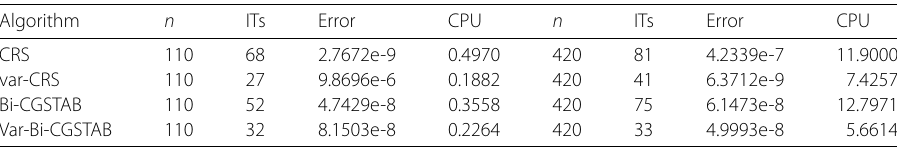
Table 4 Numerical results for Example 4.3